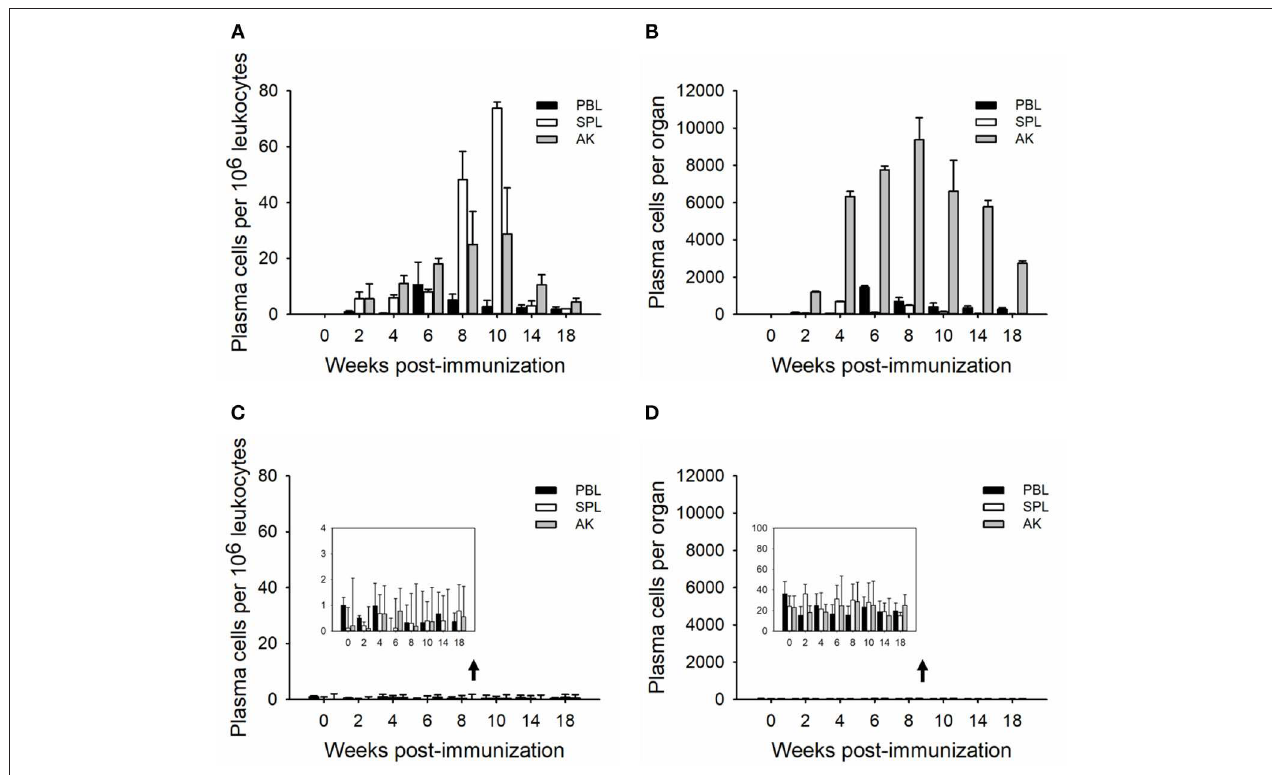
FIGURE 3 | Kinetics of TNP-specific plasma (HU-insensitive, in vitro D7). The average number per 10 6 leukocytes (A,C) and the total number in each tissue (B,D) detected in peripheral blood, spleen, and anterior kidney ( n = 5) immunized with TNP-KLH (A,B) and PBS (C,D) . Data represent the mean ± SD of five individual fish at each time point and are representative of three independent